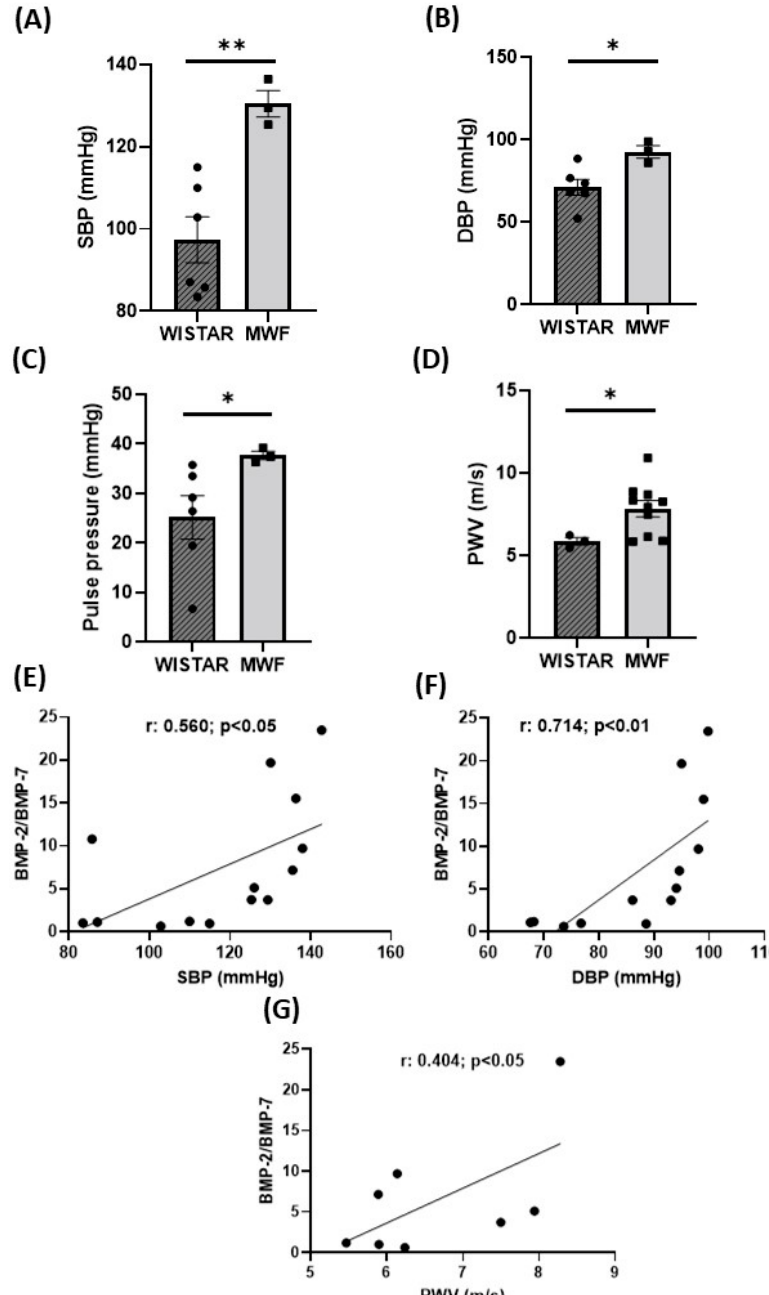
Figure 4. Hemodynamic parameters in Wistar and MWF rats. ( A ) Systolic blood pressure (SBP), ( B ) diastolic blood pressure (DBP), ( C ) pulse pressure (PP), and ( D ) pulse wave velocity (PWV) in Wistar and MWF rats. Correlation between the BMP-2/7 ratio and ( E ) systolic blood pressure (SBP), ( F ) diastolic blood pressure (DBP), or ( G ) pulse wave velocity (PWV). Data are expressed as the mean ± SEM of n = 5–11 animals per group. * p < 0.05 and ** p < 0.01 compared to Wistar.